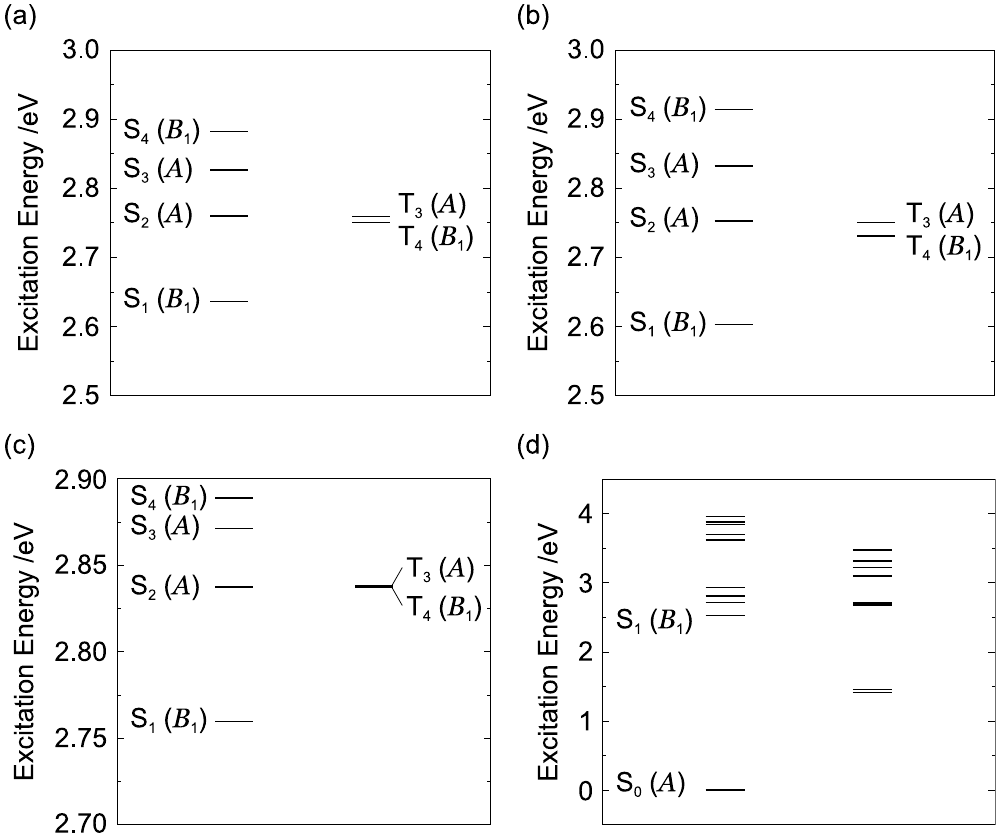
Figure 4. Energy levels of excited states at the optimized structures for ( a ) T 3 , ( b ) T 4 , ( c ) S 2 , and ( d ) S 1 .